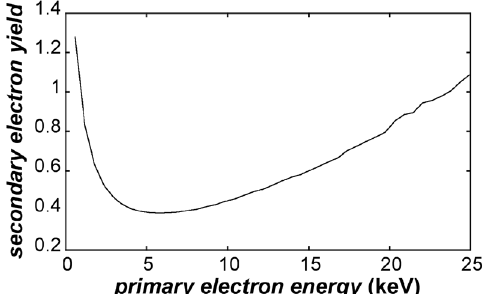
FIG. 7. Secondary electron emission induced by primary energetic electrons for a spherical MP. The location where a secondary electron is created is marked by a star.